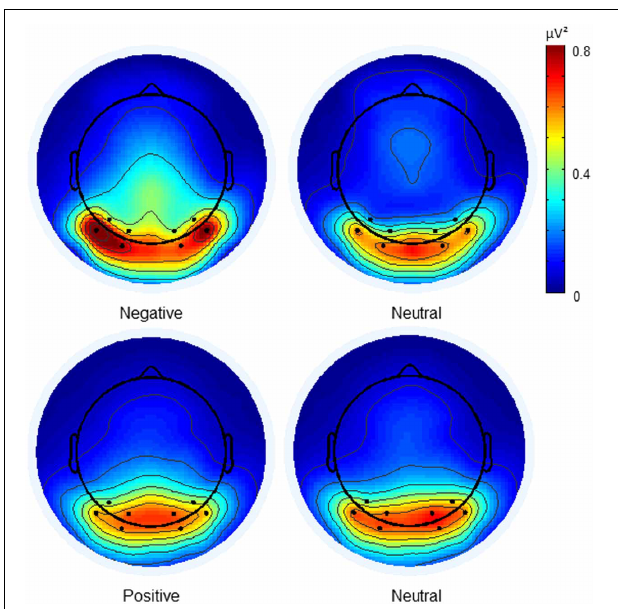
FIGURE 3 | Topographical maps of mean power values of the negative group during negative and neutral conditions. The dots indicate the electrode locations (i.e., the region of interest) chosen for statistical analysis. Power is higher in the negative condition than in its neutral condition. The positive condition and its respective neutral condition are shown for